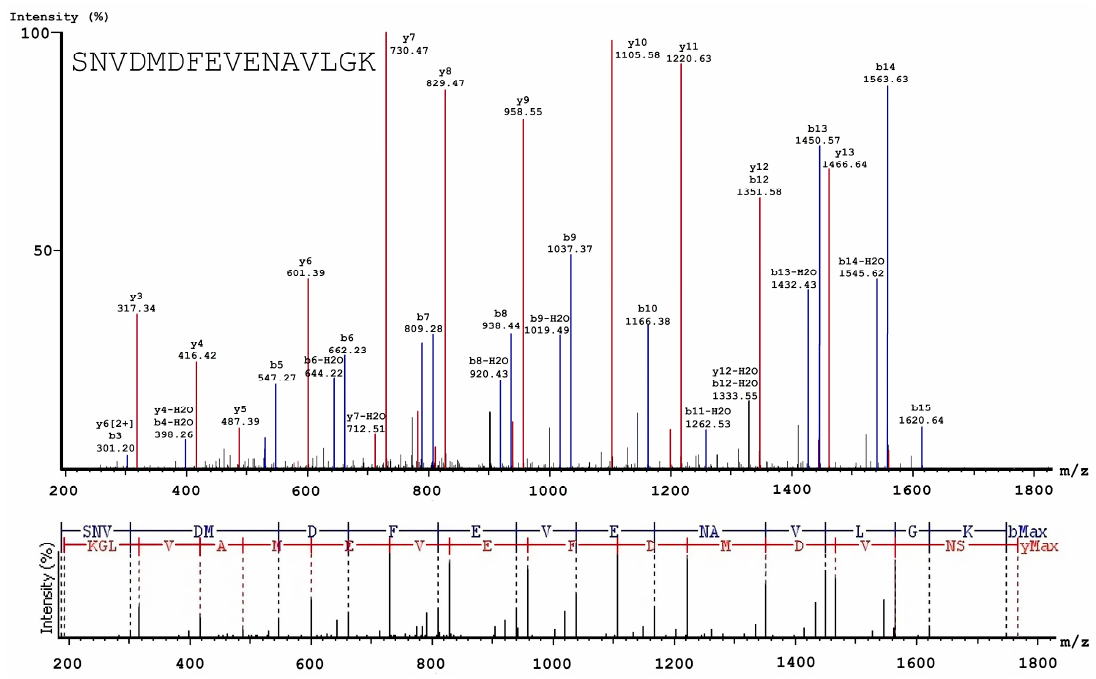
Figure 3. Representative example of the de novo sequencing validating quantification and identification of non-modified (parent) peptides. MS / MS spectrum of the doubly charged ion at m / z 883.92 for the 150 µ M oxFXIII sample identified as SNVDMDFEVENAVLGK. The y1 ion observed at m / z 147.11 was assigned to the C-terminal residue K and used to determine the remaining amino acid residues by calculating the mass difference of adjacent y-ions.